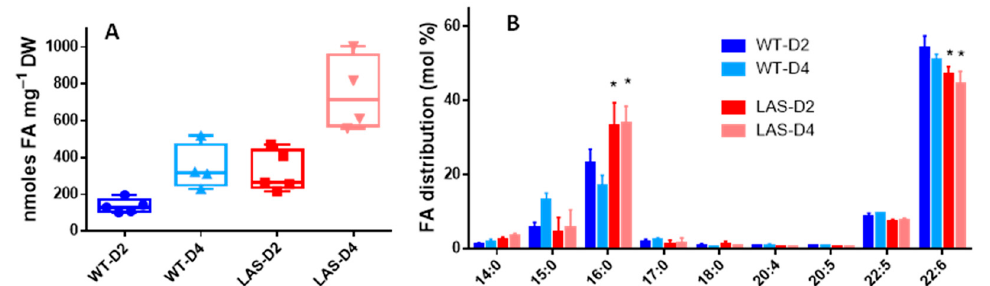
Figure 2. Analyses of FAs. ( A ) Box plots showing total FA content in WT (in blue) and LAS (in red) on day 2 (D2, end of the exponential growth phase) and day 4 (D4, stationary phase). The experiments were carried out over a period of 1 year. These Tukey representations show all points from min to max. Each point represents a different experiment and is the average of three biological replicates. ( B ) FA profiles in WT (blue bars) and LAS (red bars) on day 2 (D2) and day 4 (D4). Error bars indicate standard deviation for five (D2) and four (D4) independent experiments. Stars indicate statistical differences versus WT ( t test, p value < 0.05). Graphs and statistics were done with GraphPad Prism ® v7.00 software.